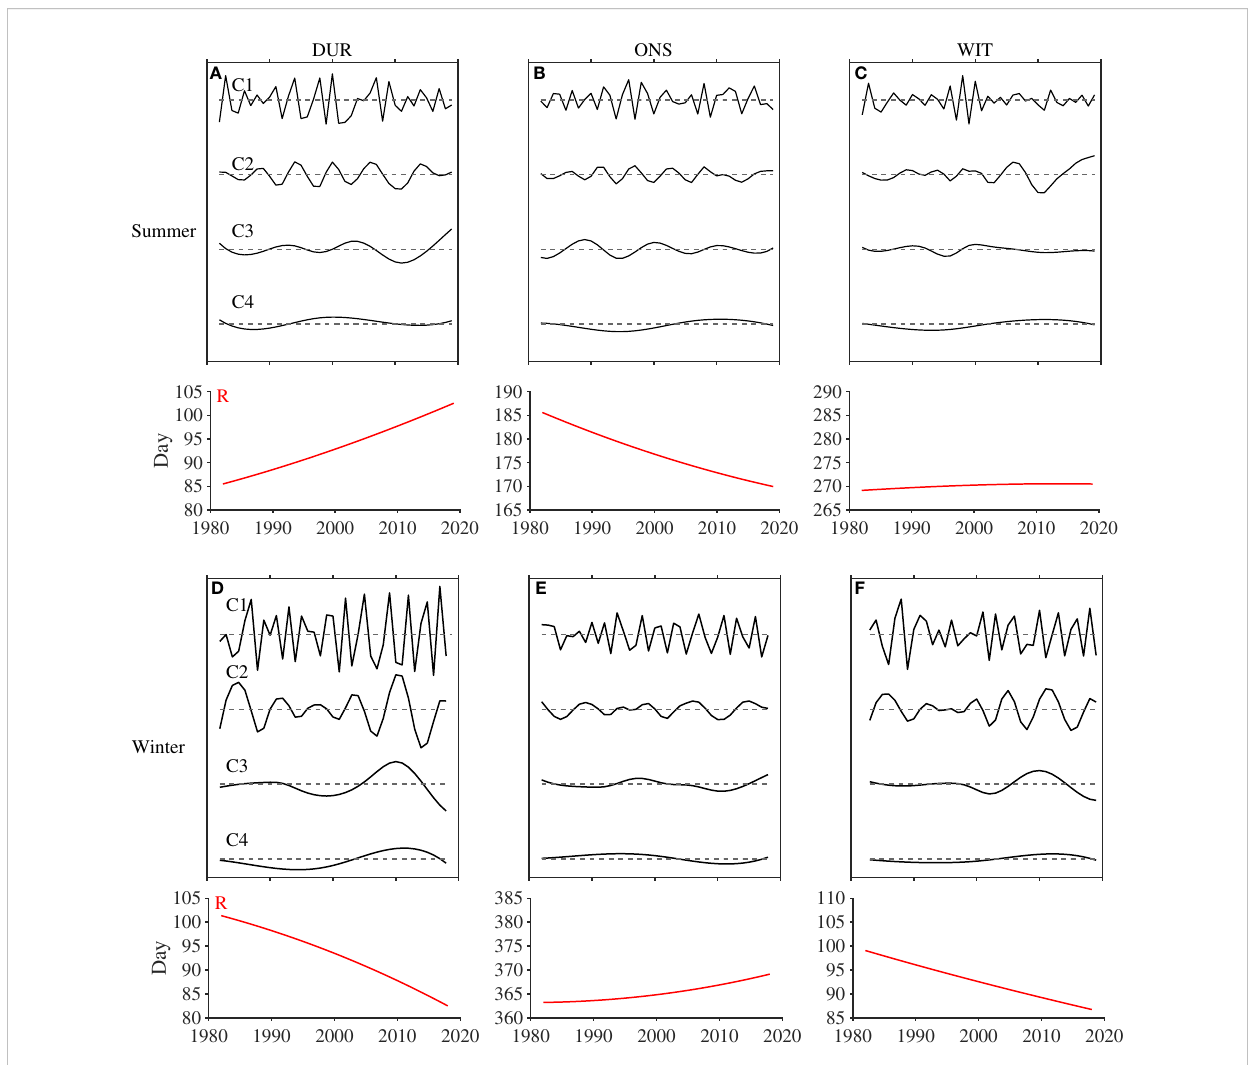
FIGURE 5 EEMD decompositions of the length and timing indices time series of (A, D) DUR, (B, E) ONS, and (C, F) WIT averaged over the Bohai Sea for the summer (upper panel) and winter (lower panel) seasons during the last four decades, respectively. The black curves (C1, C4) denote the oscillatory components; The red curves (R) denote the secular trends of the time